Question: Summarize what this figure shows in one sentence.
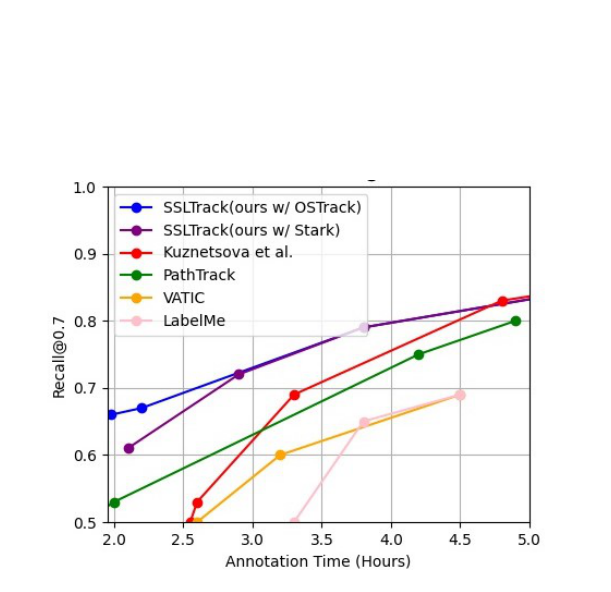
Answer: Performance comparison of our method against other state-of-the-art methods on MOT15 dataset. Our method using both automated trackers, OSTrack and Stark, outperforms all other methods and achieves higher accuracy at a lower annotation rate.